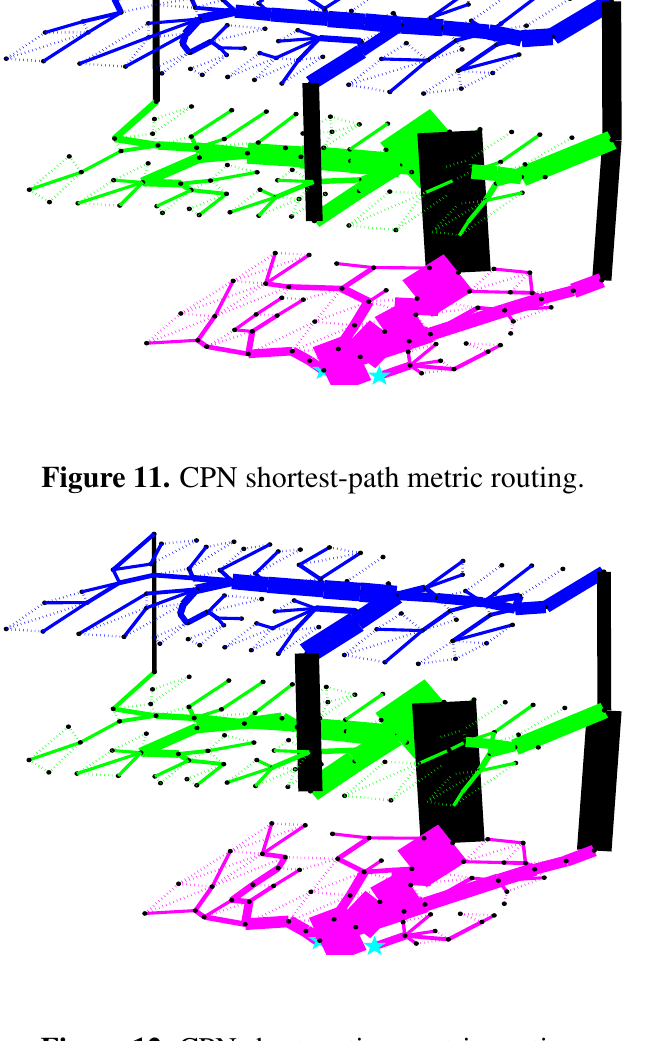
Figure 12. CPN shortest-time metric